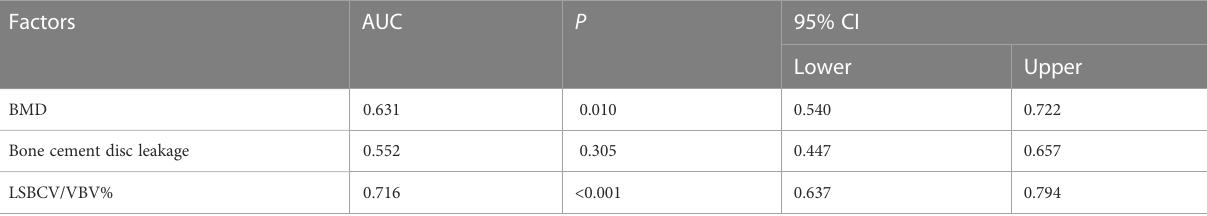
TABLE 3 Area under the ROC curve for the diagnosis of AVCF.